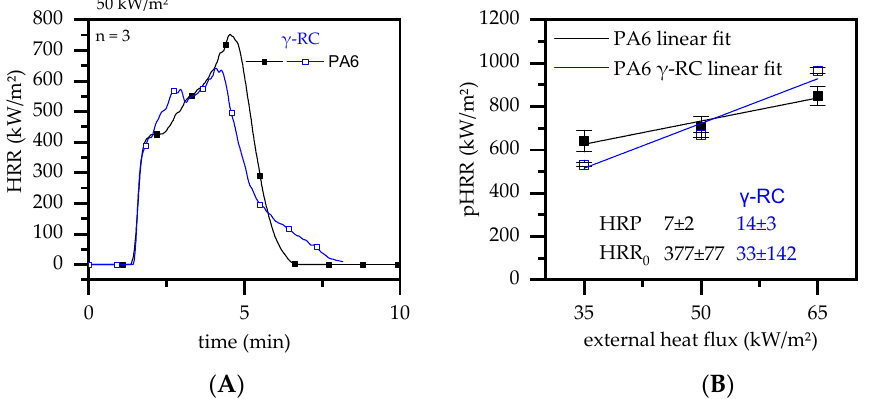
Figure 10. ( A ) HRR curves conducted by cone calorimeter testing for net and β‐ radiation β‐ RC PA6 at 50 kW/m 2 . ( B ) pHRR conducted by cone calorimeter tests at an external heat flux of 35, 50 and 65 kW/m 2 . A linear fit was used to evaluate the HRP and corresponding y ‐ cross point HRR 0 .